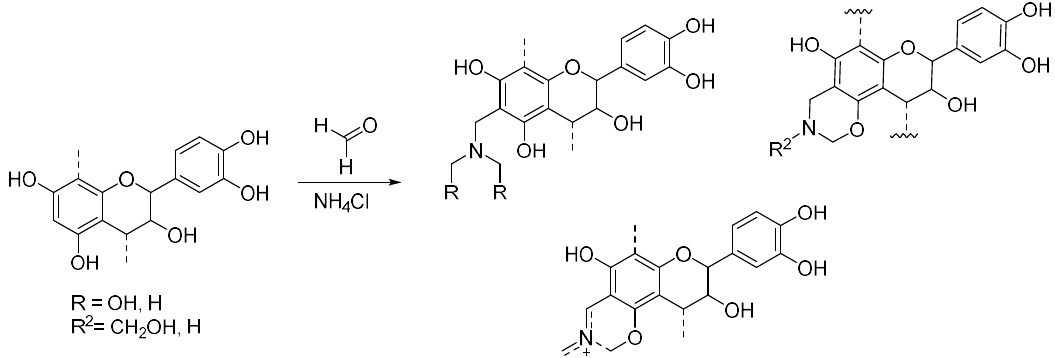
Figure 1. Possible products of the Mannich reaction with Acacia tannin .